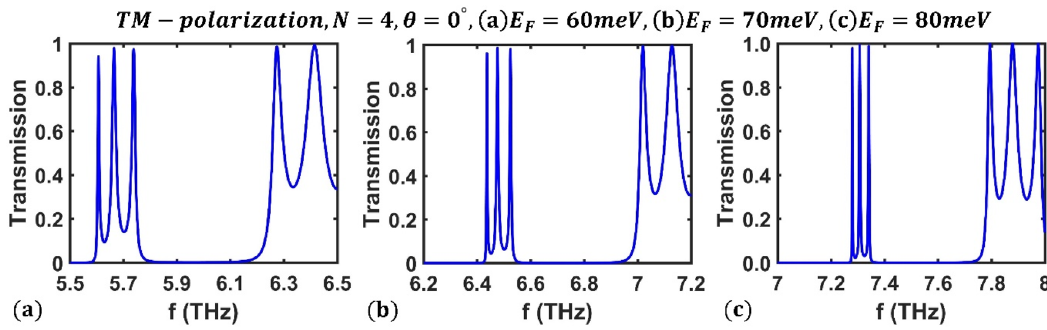
Figure 9. The transmission spectrum of the third-order F-1D PhC for TM polarization state under normal incidence corresponding to period numbers N = 4 and Fermi energies, ( a ) E F = 60 meV, ( b ) E F = 70 meV, and ( c ) E F = 80